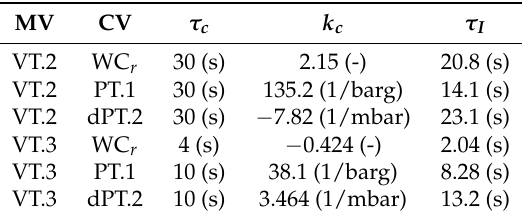
Table 5. PI controller parameters.